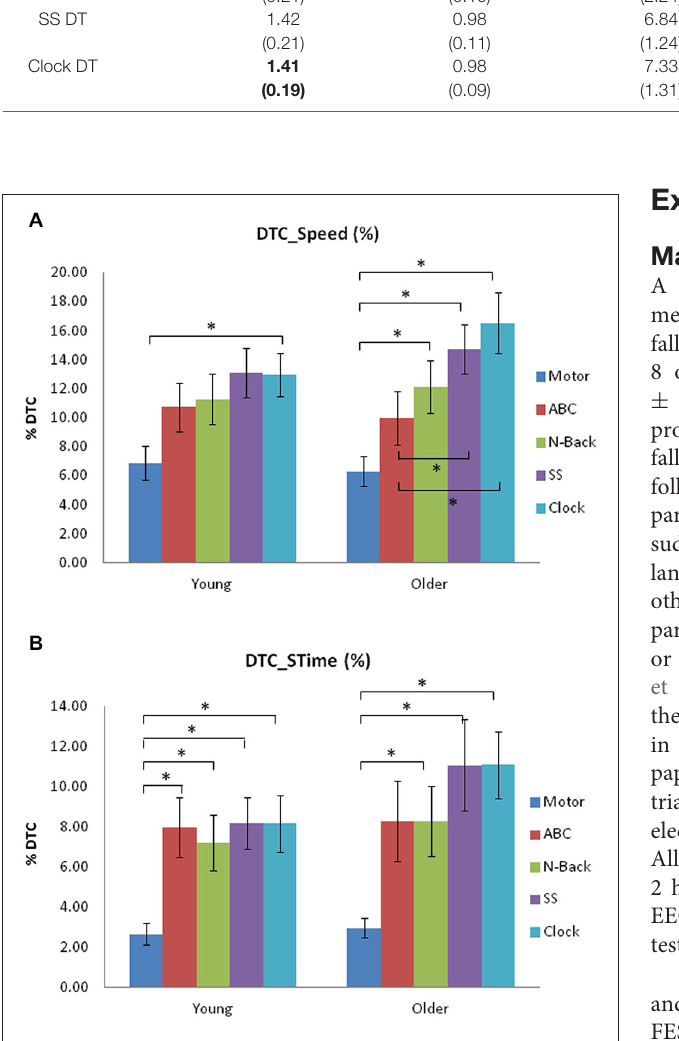
FIGURE 1 | (A) Dual-task (DT) Costs (DTC; %) on speed from single-task to each DT for young and older adult groups for the five concurrent tasks used in Experiment 1. (B) Dual-task Costs (DTC; %) on stride time (STime) from single-task to each DT for young and older adult groups in Experiment 1. Significant differences are indicated by asterisks: * p <